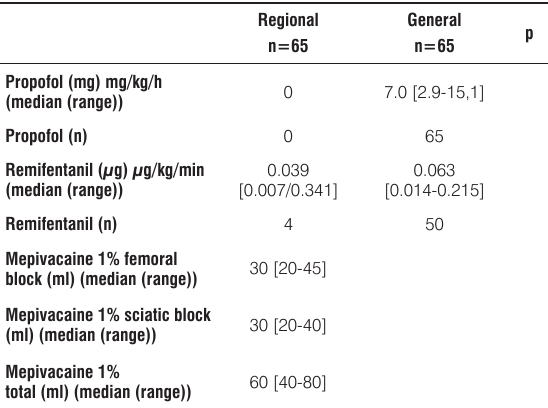
Table 2. Administered amounts of anesthetic